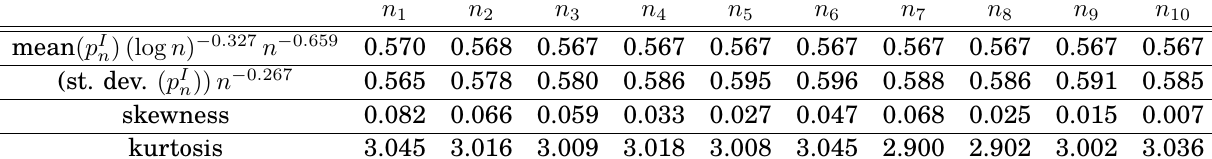
Table 3: Monte Carlo simulation results for the model-I.